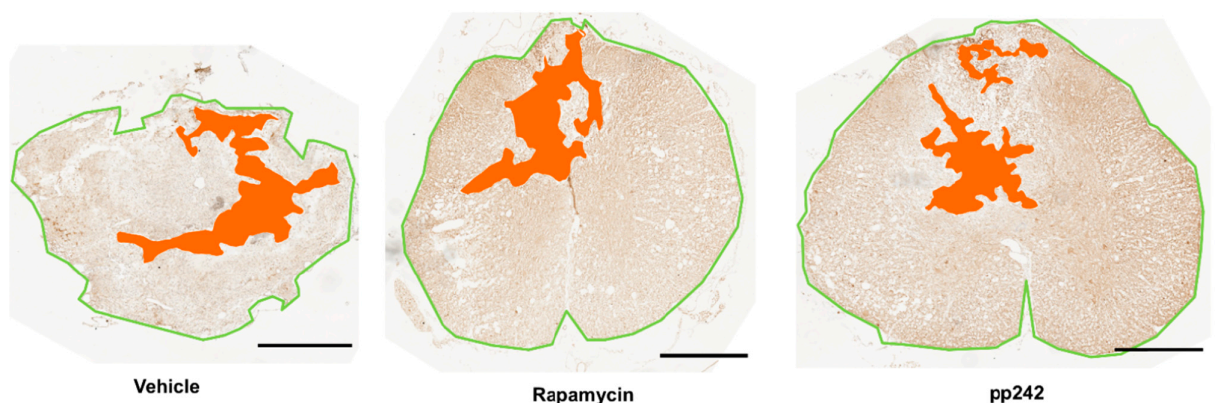
Figure A2. Representative images of lesion size evaluation. Orange areas represent the lesions, while green lines enclose the spinal cord section. Scale bars: 500 µ